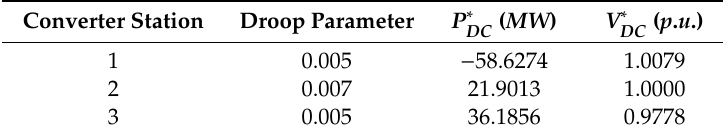
Table A12. Droop control settings for each converter station.